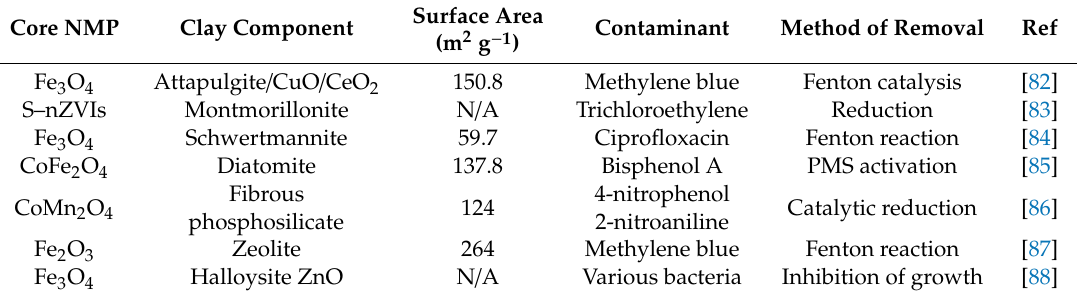
Table 4. Magnetic nanocomposites functionalized with minerals which were reported to have catalytic activity against